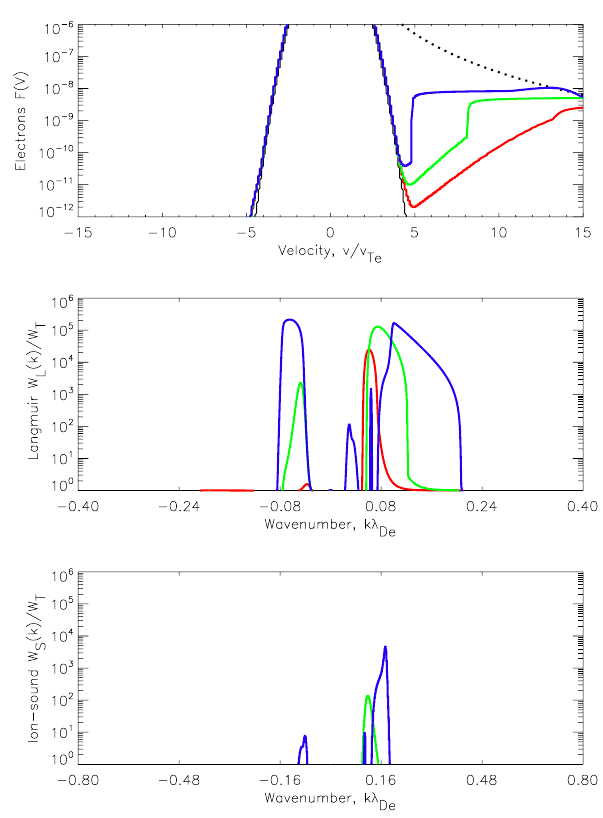
Fig. 12. Electron distribution function f (v) [cm − 4 s], Lang- muir waves, W k (k)/W T , and ion-acoustic waves, W s plasma parameters at 700km at 25, 30, and 35ms (red, green, and blue lines, respectively). The dotted line in the electron distribution panel gives the initial electron distribution g 0 (v) (the power-law fit to the satellite data at